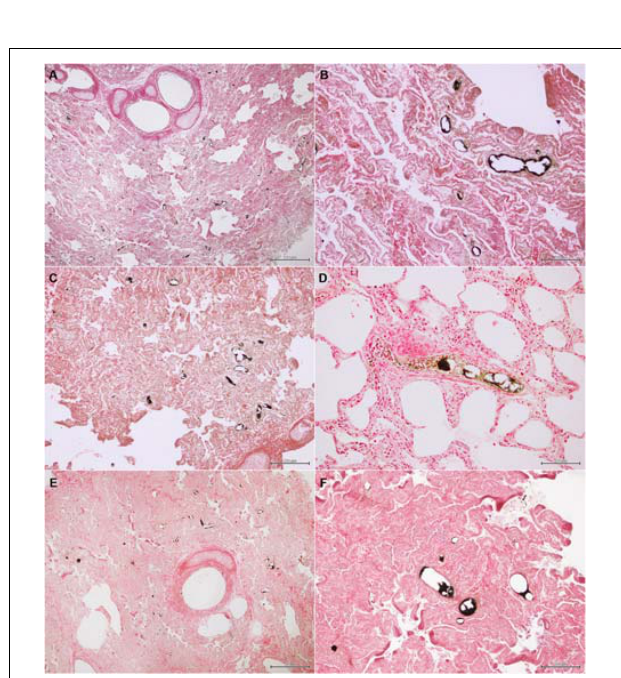
FIGURE 3 | Black stained (OsO 4 -positive) fat emboli in the lung microvasculature, mainly arterioles, of some of the sperm whales stranded in the Canary Islands with signs of ship strike (A–F) . Bar: A = 500 µ m; B = 100 µ m; C = 200 µ m; D = 100 µ m; E = 500 µ m; F = 200 µ m.